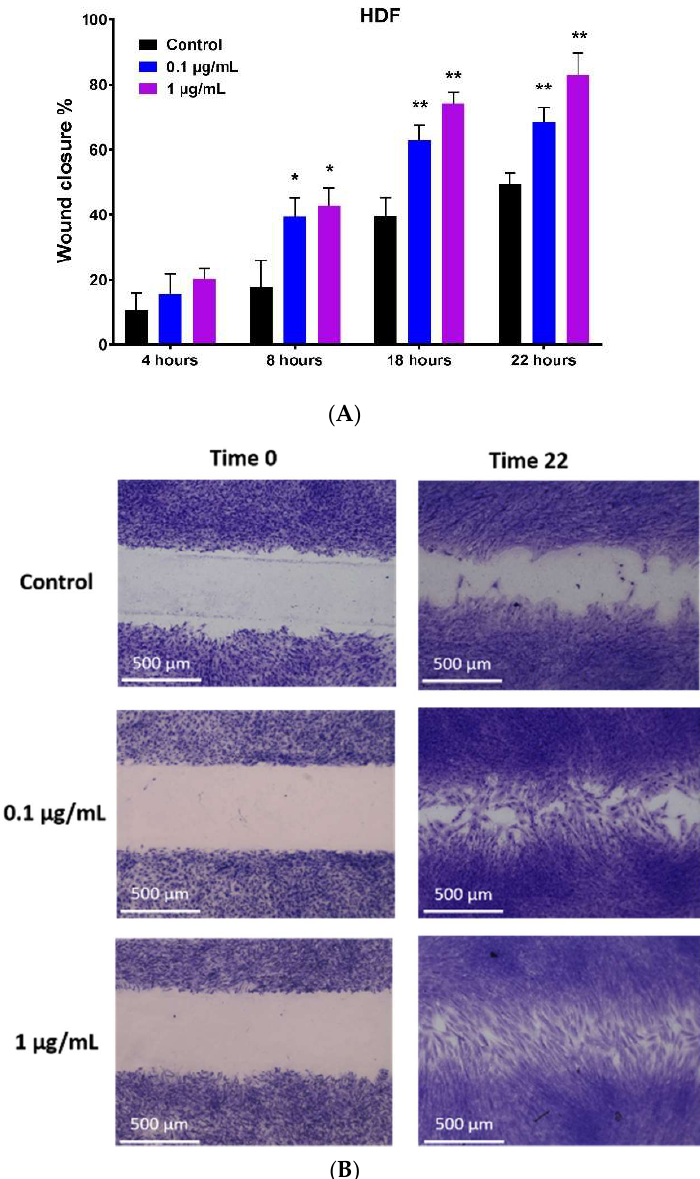
Figure 3. Migration assay of hypermongone C. ( A ) Wound closure percentage of HDFs after different time intervals of exposure to different concentrations of hypermongone C. The compound at a concentration of 1 µg/mL demonstrated the highest migration over 22 h. Multiple t-tests were performed using Graph-Pad Prism 7.03 to determine the significance between each experimental group and control (* p ≤ 0.05 and ** p ≤ 0.01). ( B ) Representative images of each treatment group after 22 h.